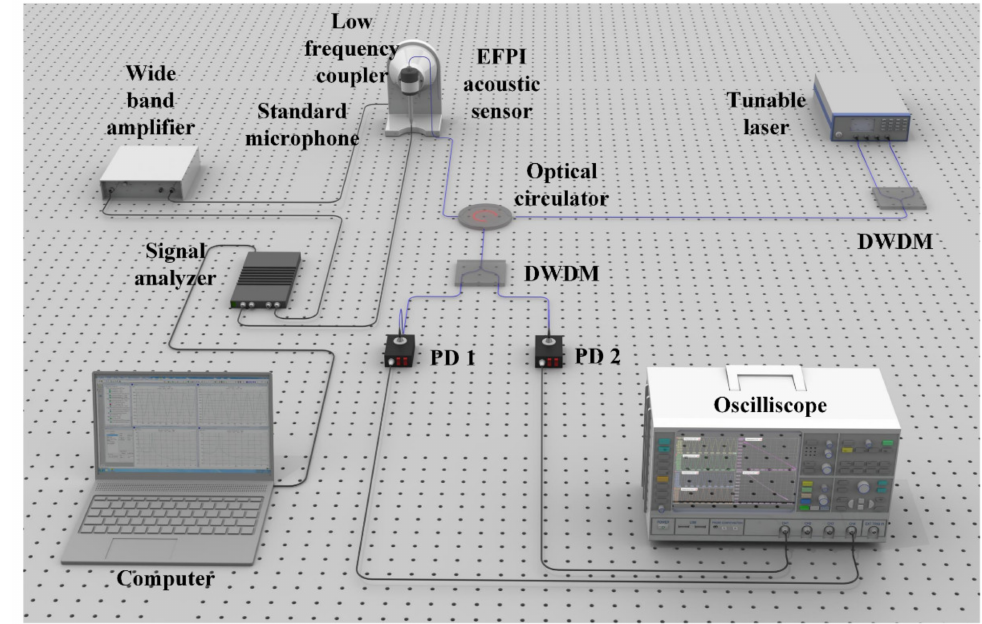
Figure 2. Acoustic signal testing